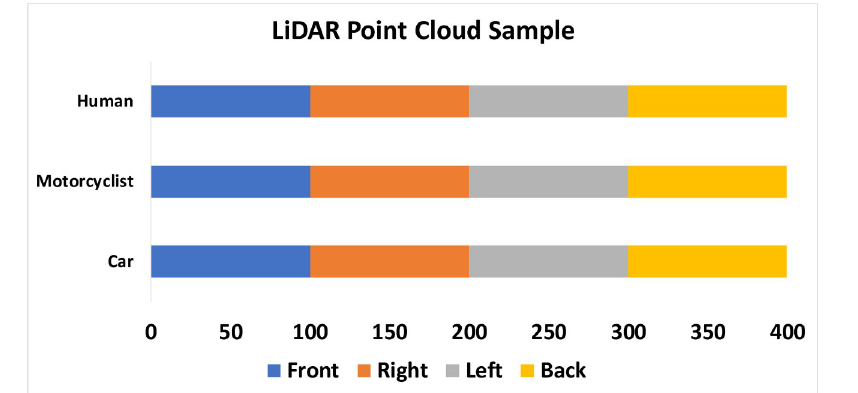
Fig 2. No of point cloud samples for each class and its pose